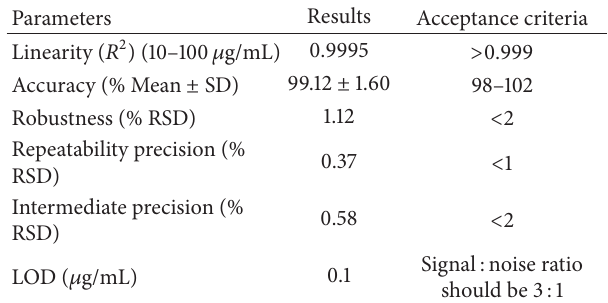
Table 1: Data of analytical method validation of CUR by